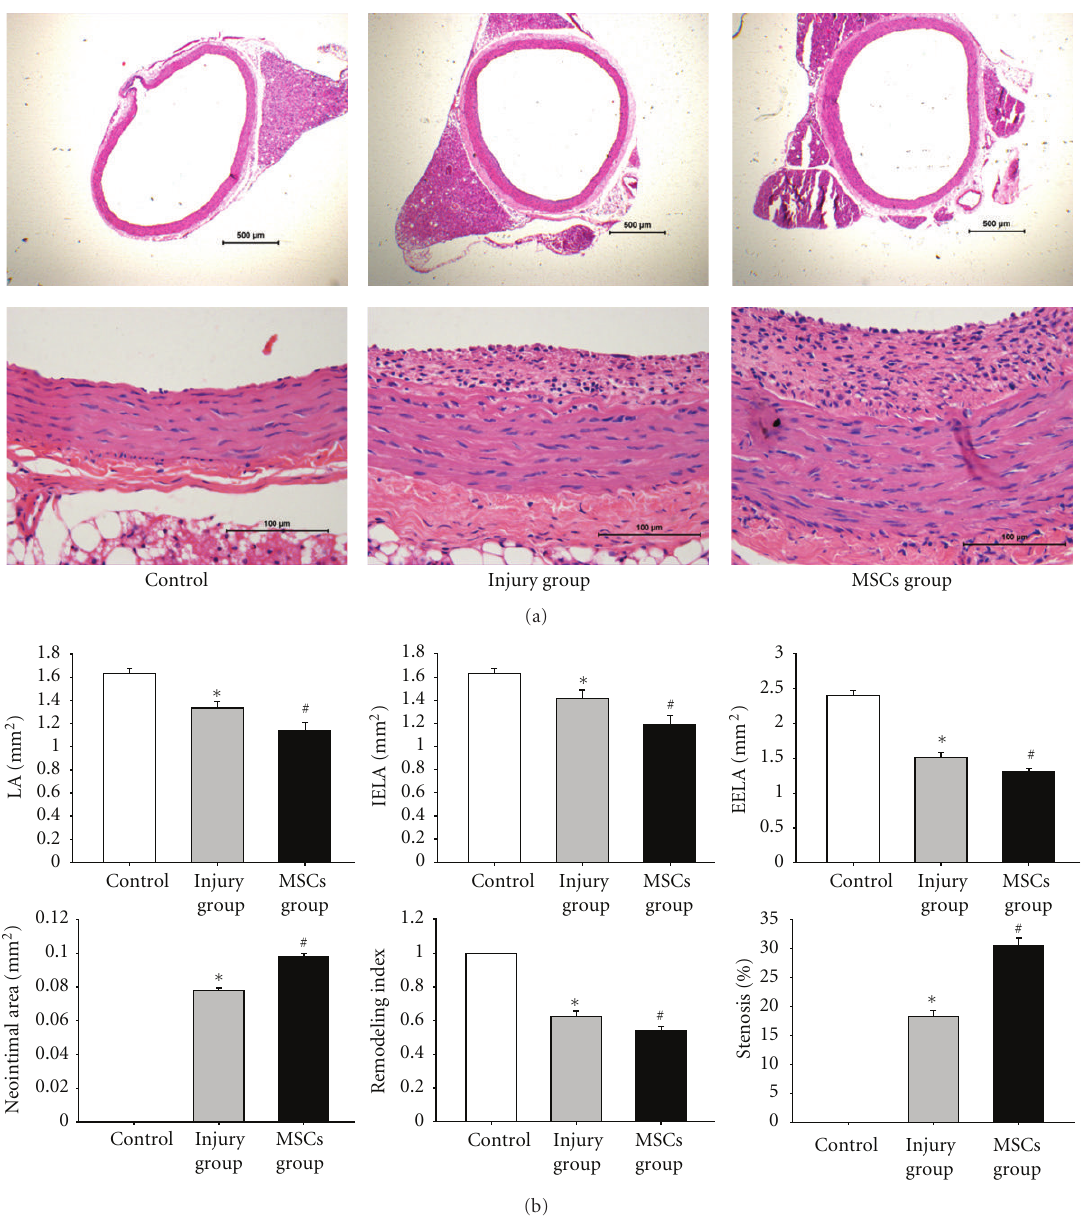
Figure 2: E ff ect of BM-MSCs on vascular remodeling after balloon angioplasty. Vascular tissues were stained with hematoxylin-eosin for morphometric analysis. (a) Ruptured internal elastic lamina was present at the site of lesion, whereas splitting of the intima was replaced with significant neointimal formation after balloon angioplasty. (b) Histomorphometric parameters including LA, IELA, EELA, remodeling index, neointimal area, and percentage of stenosis indicated vascular negative remodeling. The scale bar indicated 500 µ m (top row, 40x) and 100 µ m (bottom row, 400x), respectively. The data were expressed as means ± SEM. n = 8 per group. ∗ P < 0 . 05 versus control, # P < 0 . 05 versus injury